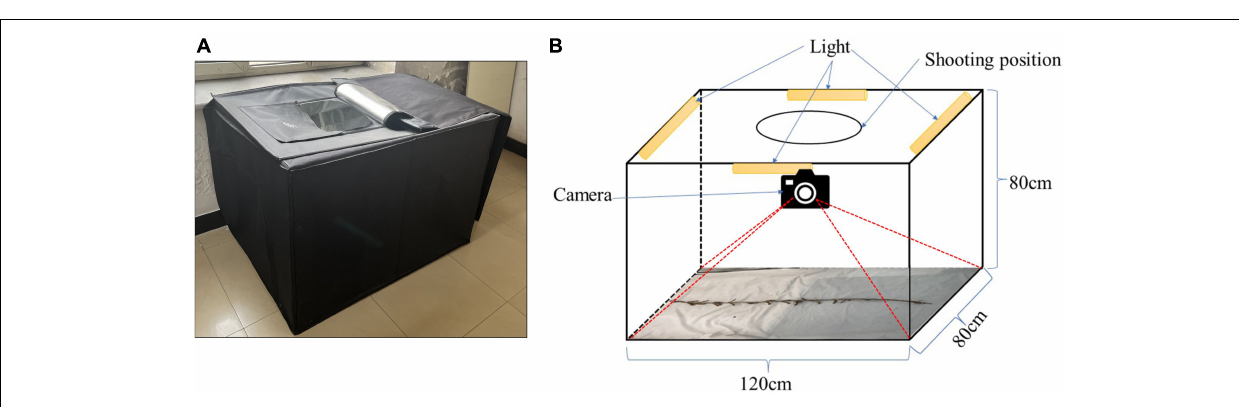
FIGURE 2 | Soybean image collection cuboid darkroom: (A) real map and (B) structural